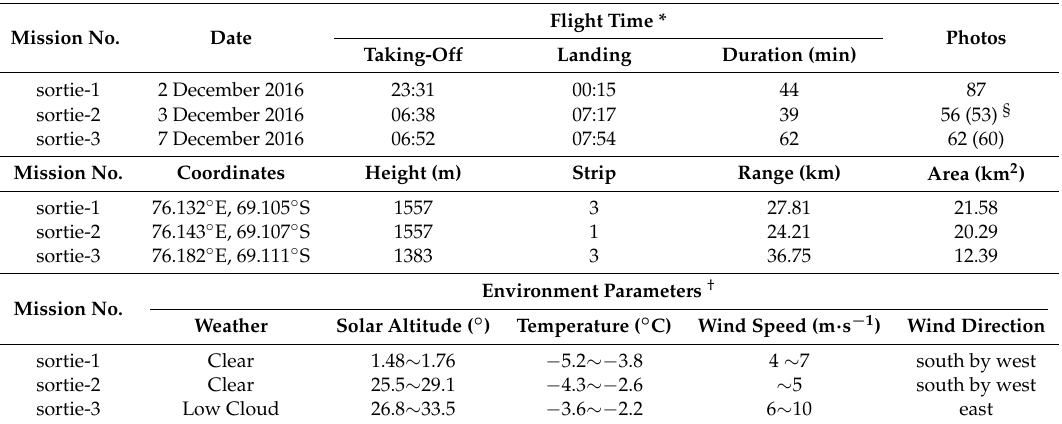
Table 1. In-situ records of three (UAS)